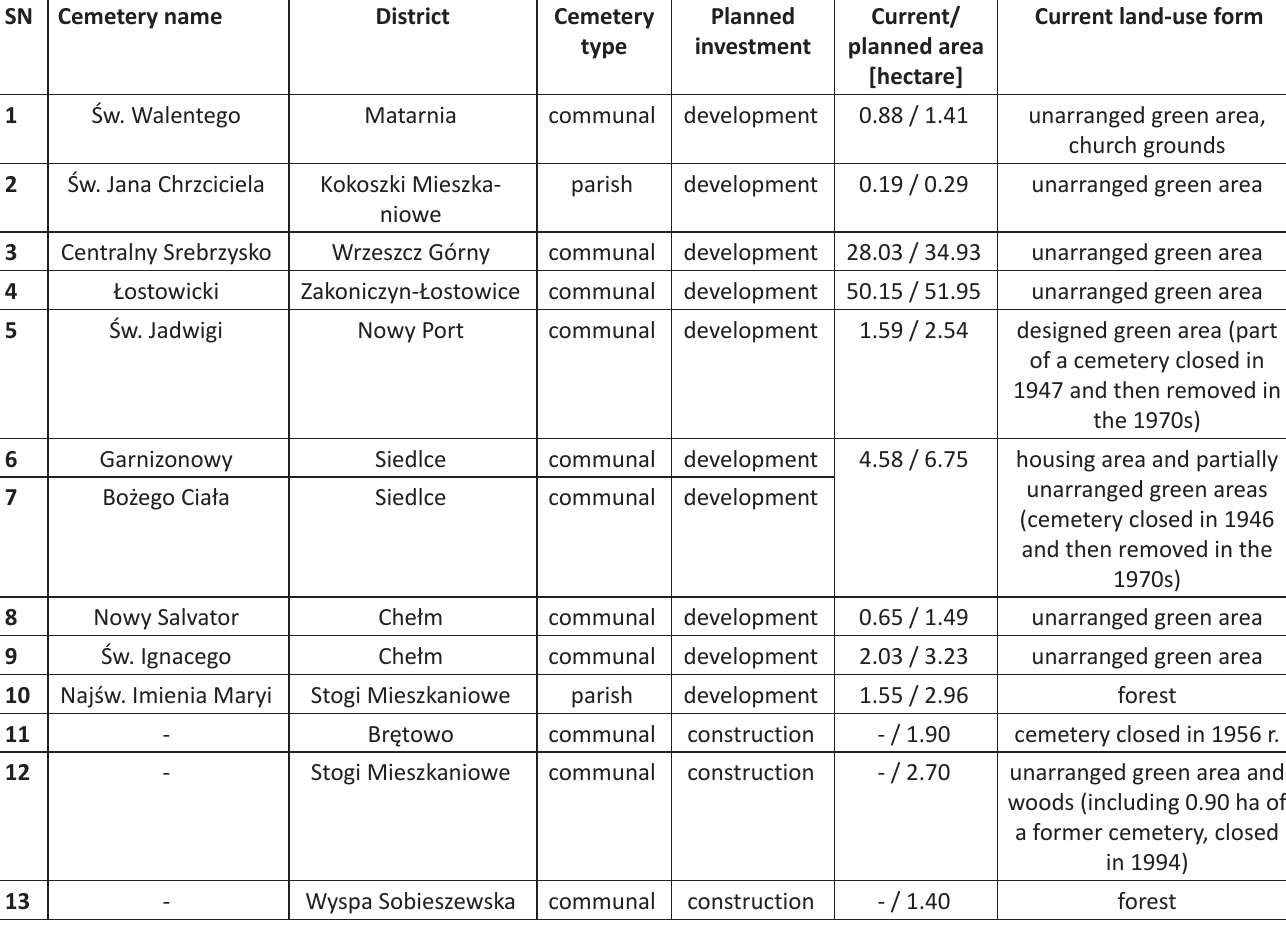
Table 1. Development plans regarding cemeteries in Gdańsk. Source: Own elaboration based on dispersed sources.